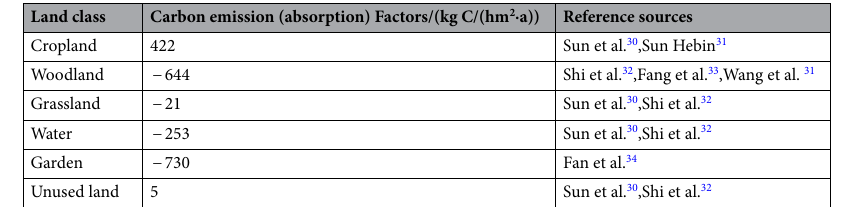
Table 2. Carbon emission estimation coefficient of nonconstruction land in the Yellow River Delta.